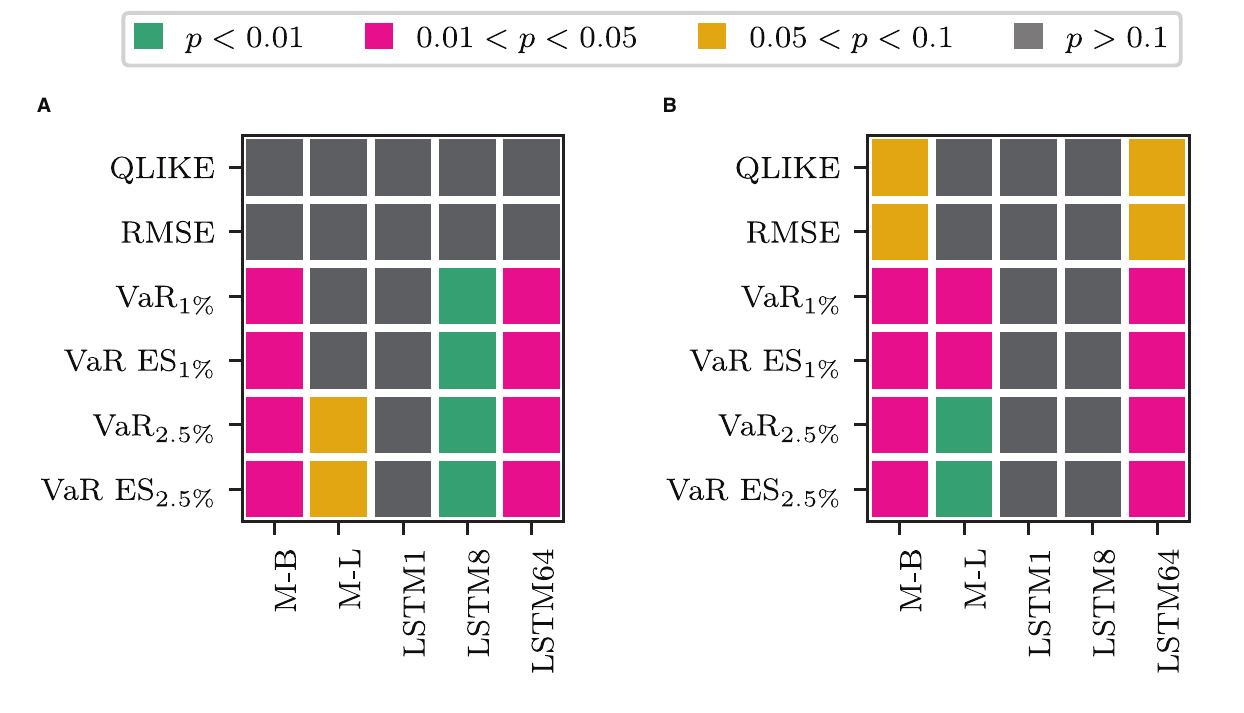
FIGURE 5 | Results for a Binomial test of equal forecasting performance between the models that combine the transformed measure with the HAR inputs and their counterpart that uses the LSTM cell applied to log RV. (A) HAR-F vs LSTM-F. (B) HAR vs